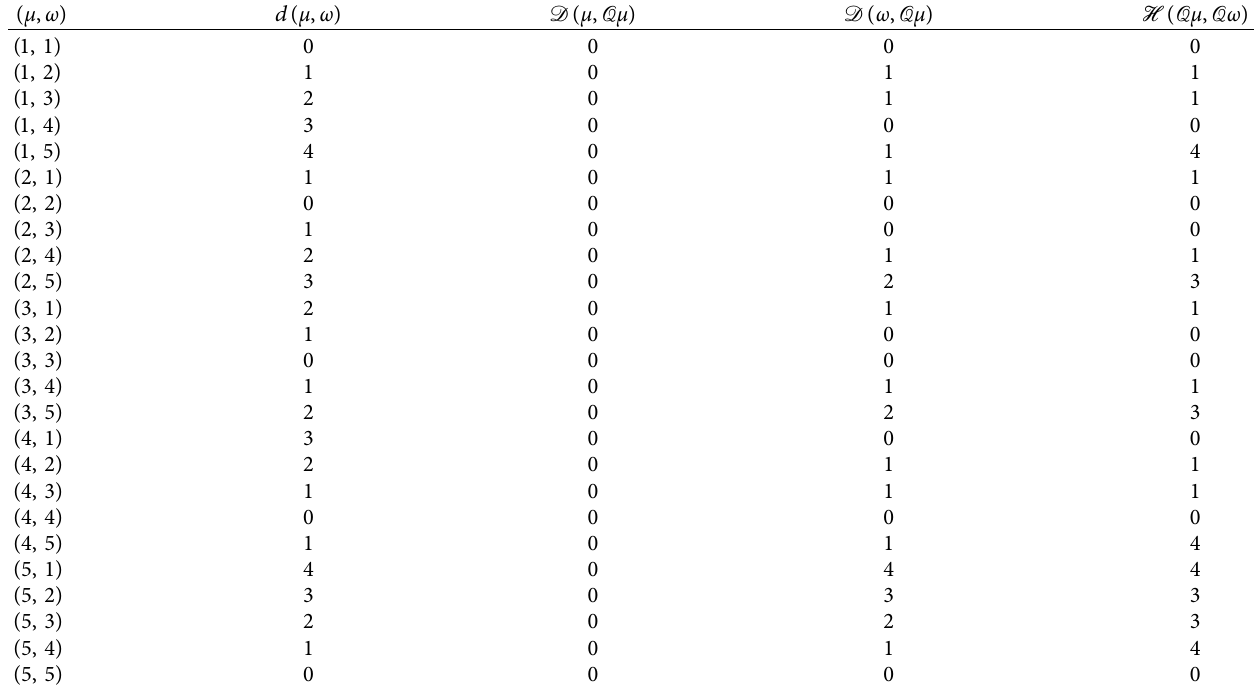
Table 1: Values of d , D , and H